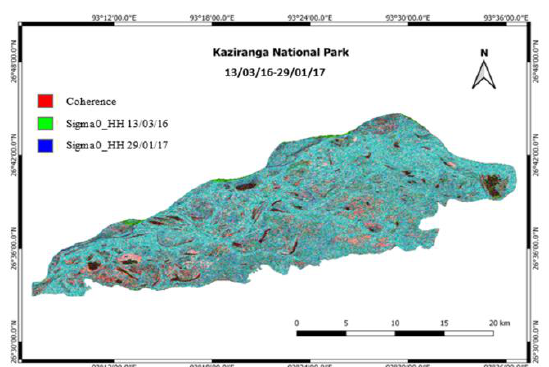
Figure 11. RGB composite of coherence between 13/03/16 & 29/01/17 (R), sigma0_HH of 13/03/16 (G)